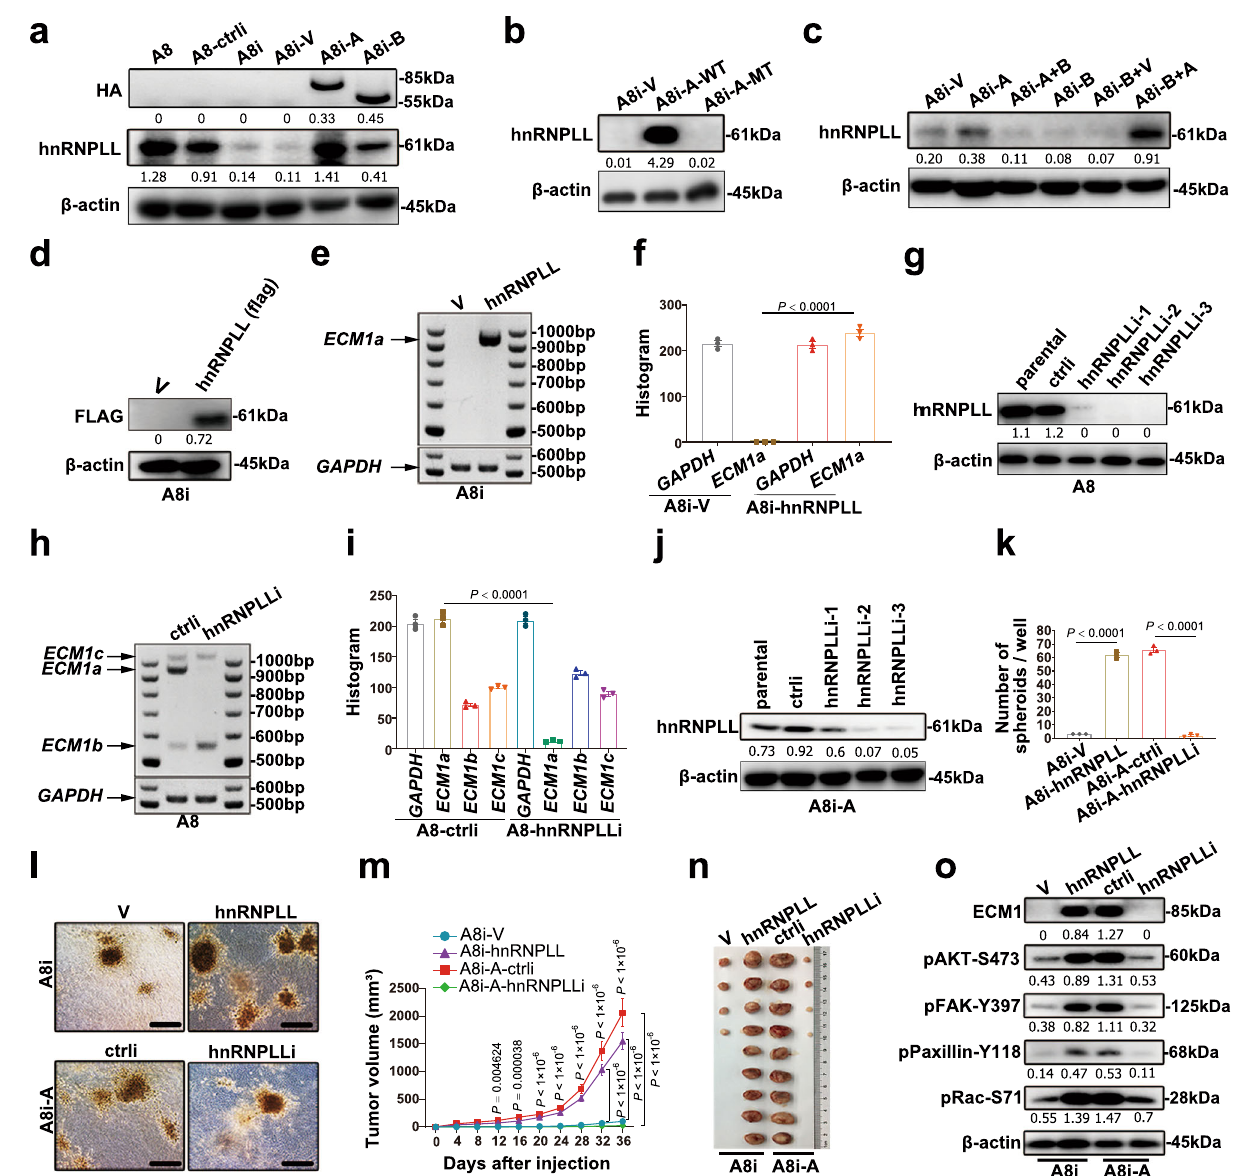
Fig. 5 hnRNPLL determines ECM1a mRNA splicing and ECM1a-associated signaling and tumor growth. hnRNPLL protein expression in ECM1-silenced and ECM1a-overexpressing cells ( a ), in ECM1a-WT/ECM1a-MT cells ( b ), and in ECM1a- and ECM1b-cross-transfected cells ( c ). Overexpression of hnRNPLL in A8i cells ( d ) promotes ECM1a mRNA splicing, as tested by semiquantitative RT-PCR ( e ) and quanti fi cation ( f , data are presented as mean ± SD, n = 3 biologically independent repeats, two-tailed t -test). Silencing of hnRNPLL in A8 cells with speci fi c shRNAs ( g ) reduces ECM1a mRNA production but upregulates ECM1b mRNA production, as detected by semiquantitative RT-PCR ( h ) and quanti fi cation ( i , data are presented as mean ± SD, n = 3 biologically independent repeats, two-tailed t -test). hnRNPLL silencing ( j ) or overexpression inhibits or enhances 3D cell growth as shown by spheroid quanti fi cation ( k , data are presented as mean ± SD, n = 3 biologically independent repeats, two-tailed t -test) and formation ( l , bars = 400 μ m), xenograft tumor growth ( m , data are presented as mean ± SD, n = 9v9 mice, two-tailed t -test) and tissues ( n ) in nine mice, and activation of ECM1-associated signaling molecules ( o ),